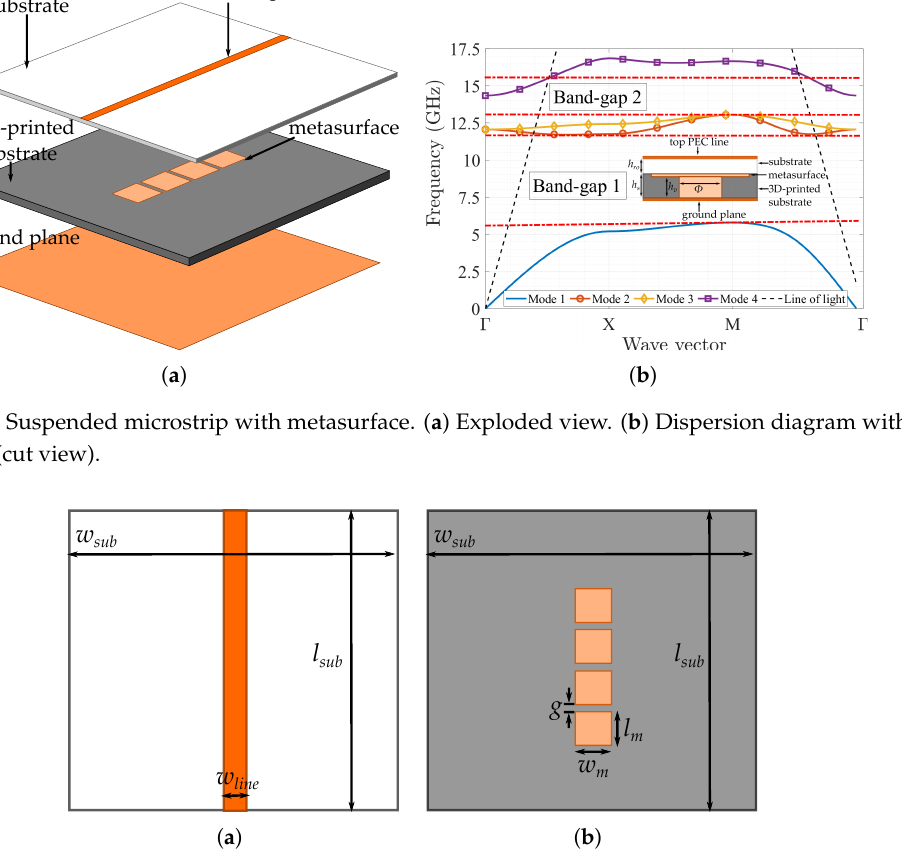
Figure 9. Top view of the designed structures for the suspended microstrip metasurface assessment. ( a ) Top-view of the microstrip line etched on a Rogers4003 substrate. ( b ) Top-view of the 1 × 4 mushroom metasurface.